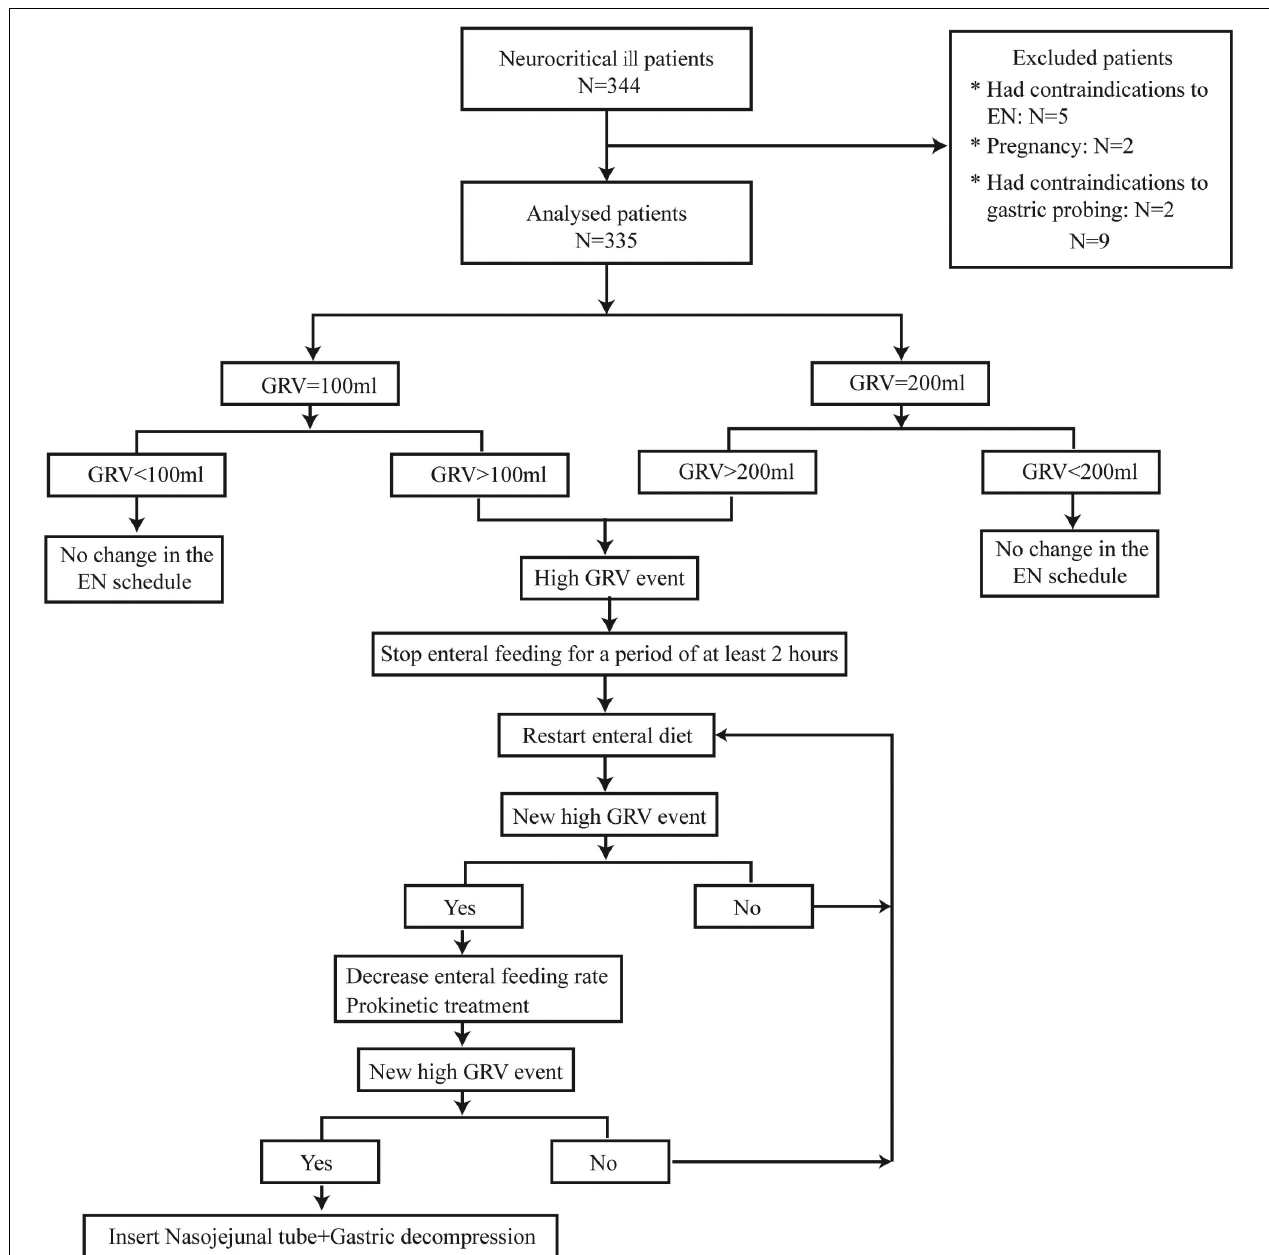
FIGURE 1 | The study flow